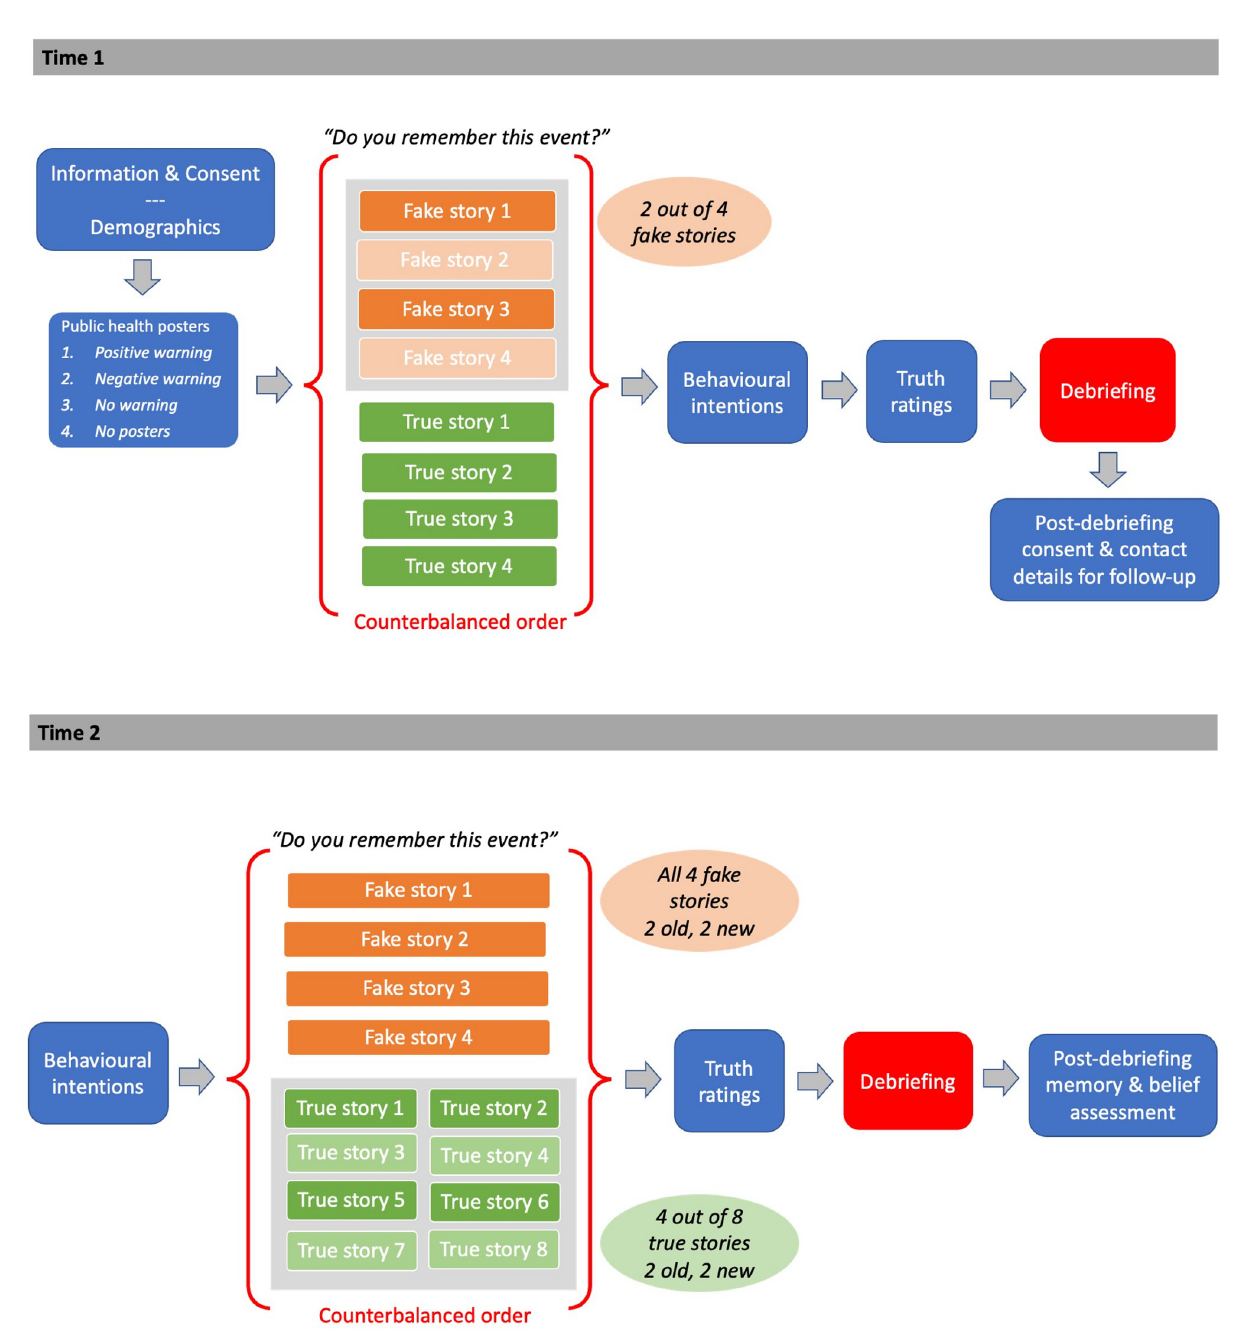
Fig 1. Schematic of experimental procedure at Time 1 and Time 2. Note: A series of measures assessing individual differences in cognitive ability and knowledge about COVID-19 were also collected at Time 1, with their presentation counterbalanced with the measures described here. These measures are not relevant to the present paper, and so are omitted from this schematic in the interests of